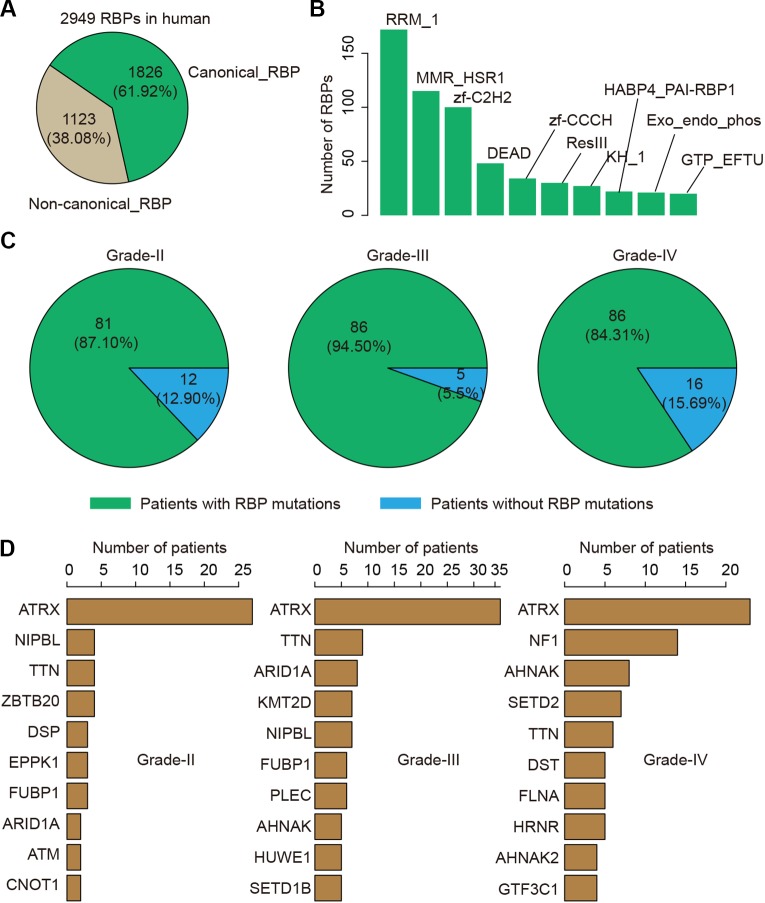
The mutation spectrum of RNA-binding protein (RBP) mutations in glioma. (A) The pie chart shows the proportion of canonical and non-canonical RBPs. (B) The bar charts shows the number of RBPs in top ranked RBP families. (C) The pie charts show the proportion of patients in different grade with RBP mutations. Left for grade II, middle for grade III and right for grade IV. (D) Top ranked 10 genes by mutation frequency in different grades. Left for grade II, middle for grade III and right for grade IV.